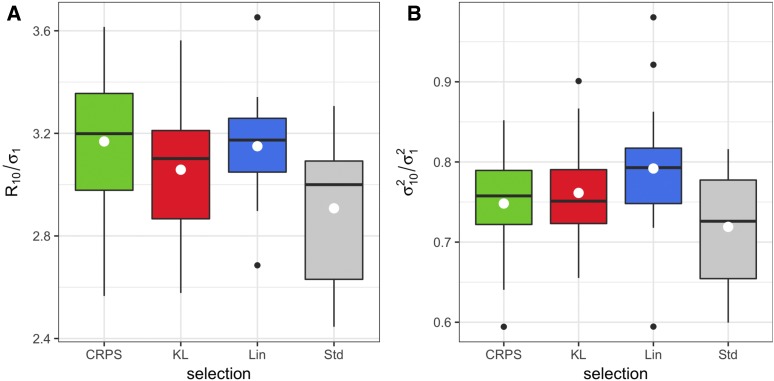
Results of the univariate simulation study at the 10th selection cycle for 30% of selected lines. A) Boxplots of the standardized selection response; B) boxplots of the scale population variance. The boxplots illustrate the mean (white dots) and median (black middle line) of 20 replications of the simulation study. R,σ2,σ12 and σ1 were defined in Figs. B2 and B3. Sub-indices refer to the 10th selection cycle.